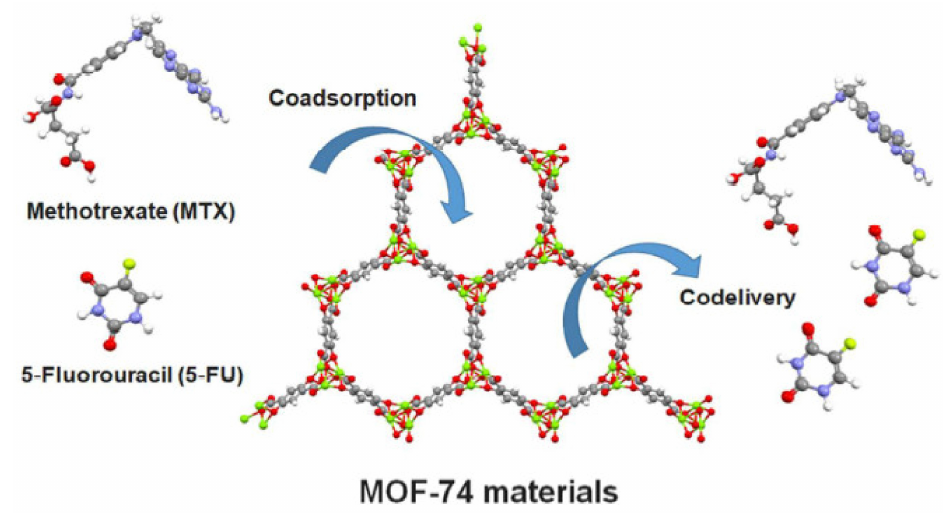
Figure 8. MD simulation of MOF-74 for the storage and delivery of anti-cancer drugs (Ref.